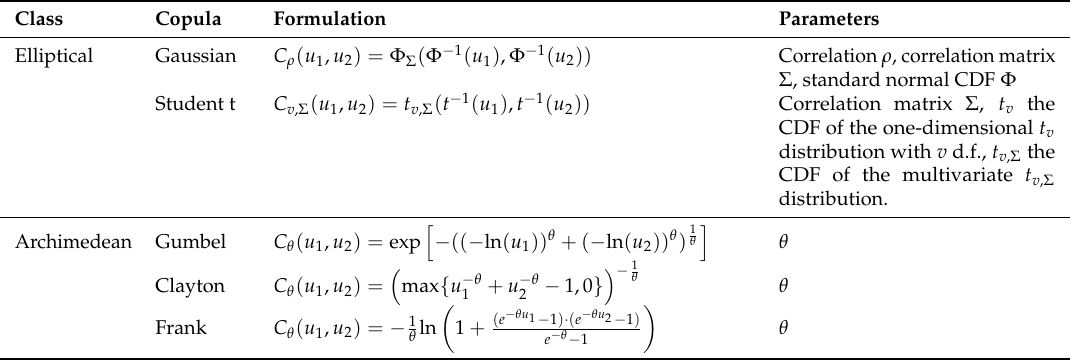
Table 2. Investigated copula types and mathematical